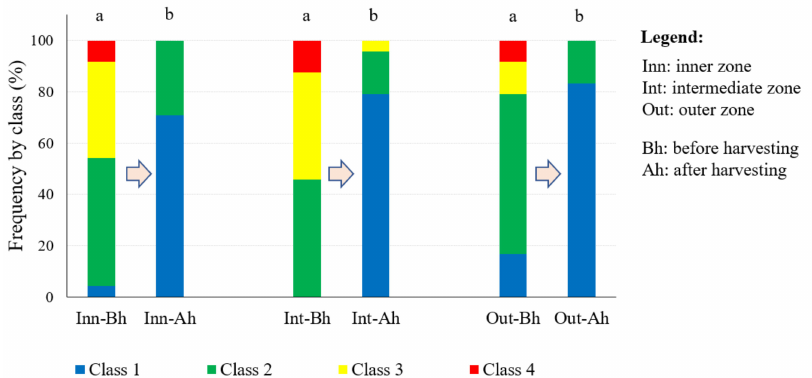
Figure 3. Qualitative comparison of quantity of fruit before and after mechanised harvesting in the different radial zones from the tree trunk in the study area (1.1 to 3.0 m above the ground). A different letter indicates significant differences (Friedman’s test, p <